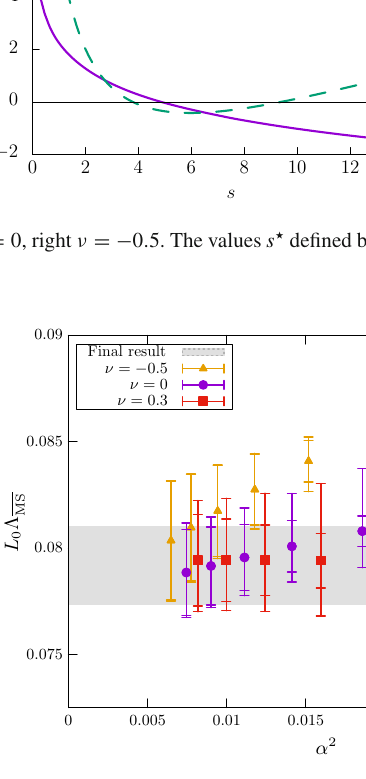
Fig. 7 Statistical (interior error band) and total (exterior error band) uncertainties in the determination of L 0 (cid:2) . The total uncertainty is MS computed by adding in quadratures the statistical and systematic uncer- tainties. The latter are computed varying the renormalization scale by a factor 2 above and below the value s (cid:20) . See text for more